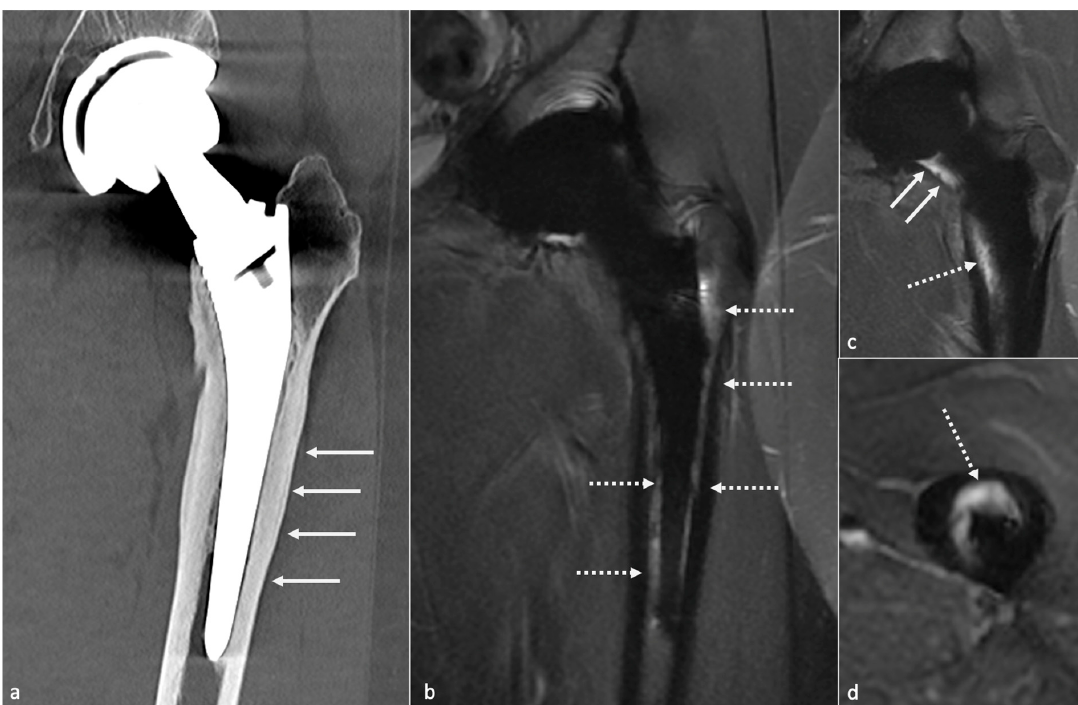
Figure 21. Stress reaction. A stress reaction is shown on ( a ) a coronal CT-scan slice with a varus stem position and asymmetric periosteal reaction (arrows). Periprosthetic bone marrow edema (dotted arrows) is doubtful on ( b ) a coronal STIR image but is depicted on another ( c ) coronal and ( d ) axial STIR image. Additionally, note the small amount of joint fluid (double arrow) on ( c ), consid ‐ ered nonspecific.